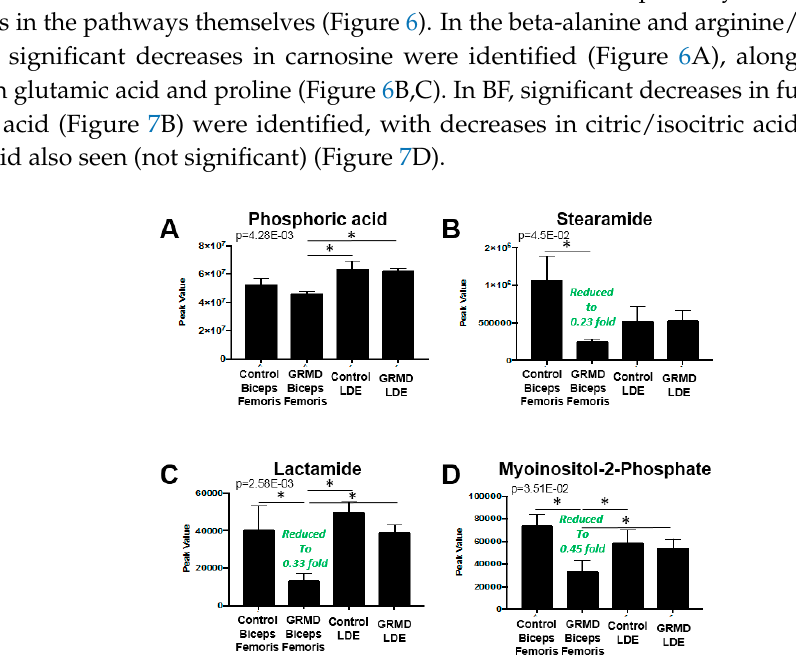
Figure 5. Comparison of Peak values of ANOVA metabolites in GRMD LDE and BF muscles by untargeted metabolomics. Peak values of GRMD LDE and BF ( A ) phosphoric acid; ( B ) stearamide; ( C ) lactamide; and ( D ) myosinositol-2-phosphate. Analysis by Metaboanalyst analysis of GRMD (N = 6) vs. control (N = 4) long digital extensor metabolites. Data is presented as the mean +/- SEM.